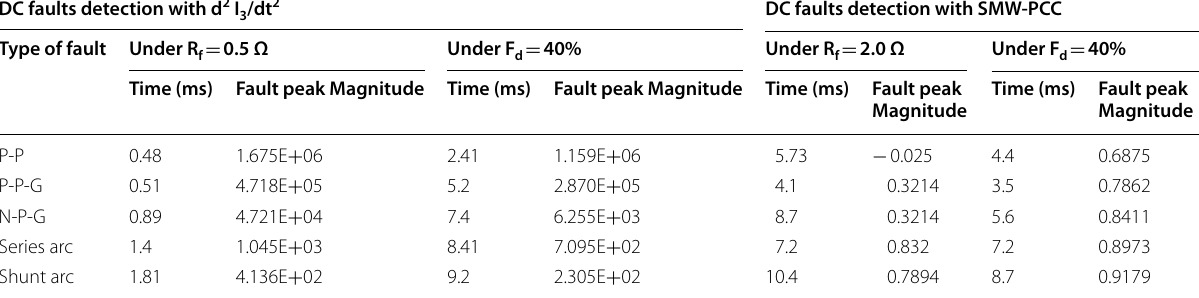
Table 4 DC faults detection using second-order differential derivative current DC faults detection with d 2 I 3 /dt 2 DC faults detection with SMW‑PCC Type of fault Under R f = 0.5 Ω Under F d = 40% Under R f = 2.0